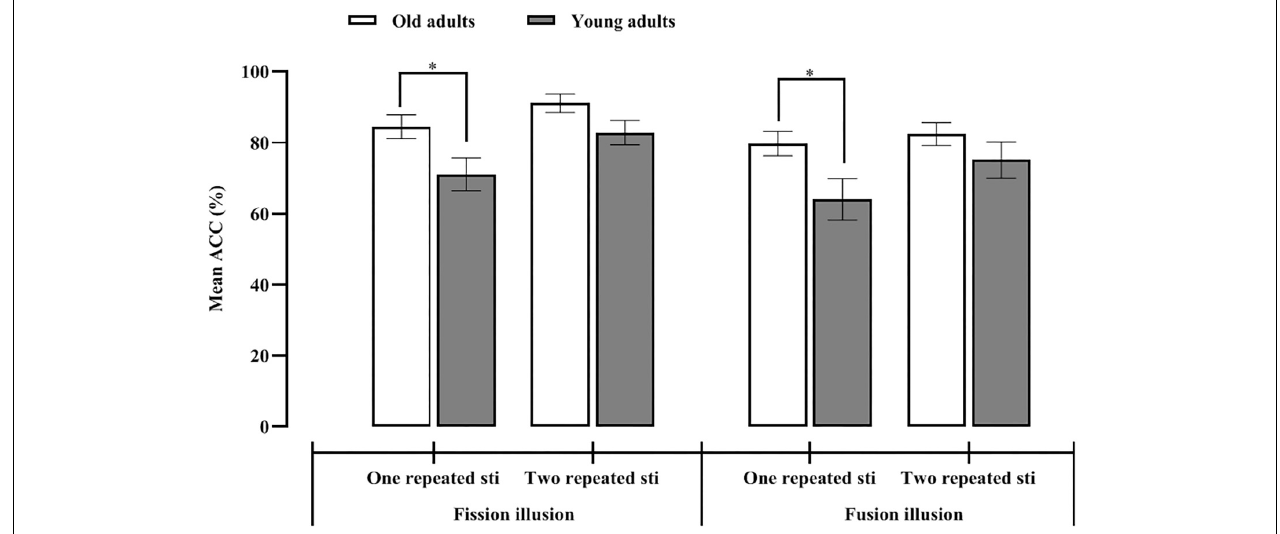
FIGURE 3 | Mean proportion of illusory responses for the one and two repeated auditory stimulus conditions in the young and old adults for the fission (left) and fusion (right) illusions.